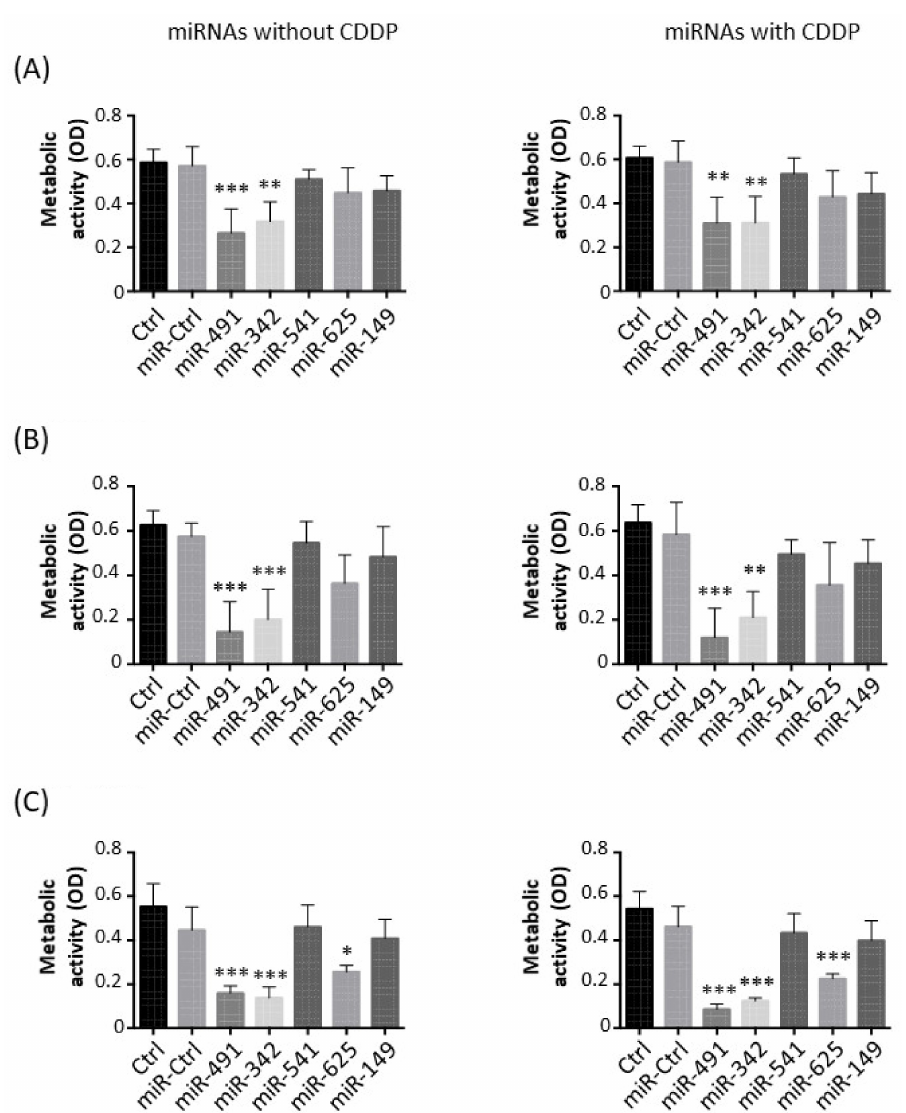
Figure 1. Effects of miRNAs on the metabolic activity of osteosarcoma cell lines. ( A ) HOS, ( B ) MG-63 and ( C ) SaOS-2 cells were grown for 24 h before transfection with 20 nM of the indicated miRNAs. After 48 h, cells were treated for 24 h with 0.5 µ g/mL CDDP. The metabolic activity was measured 72 h after transfection. Data are presented as mean optical density (OD) ± SD of four independent experiments. Statistically significant differences between miR-Ctrl and miRNA-treated cells were determined using one-way ANOVA (***: p < 0.001, **: p < 0.01, *: p <